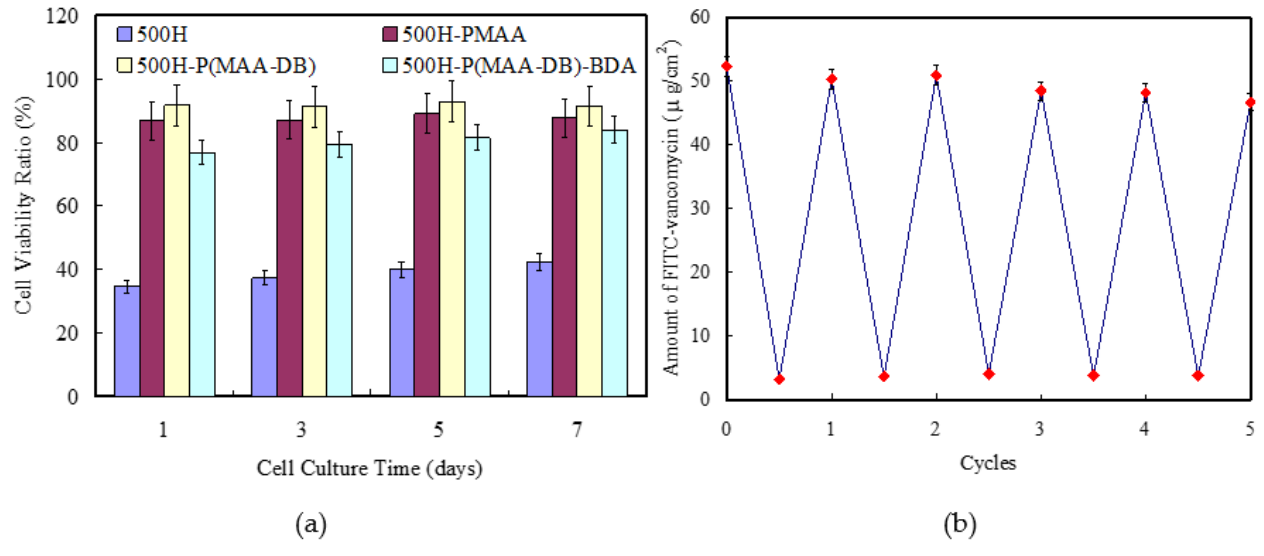
Figure 6. ( a ) Viability of L929 cells proliferated on the chips measured by CCK-8 assay ( n = 3, p < 0.05), and ( b ) amount of FITC-vancomycin inside the hole array after 5 cycles of loading and release.